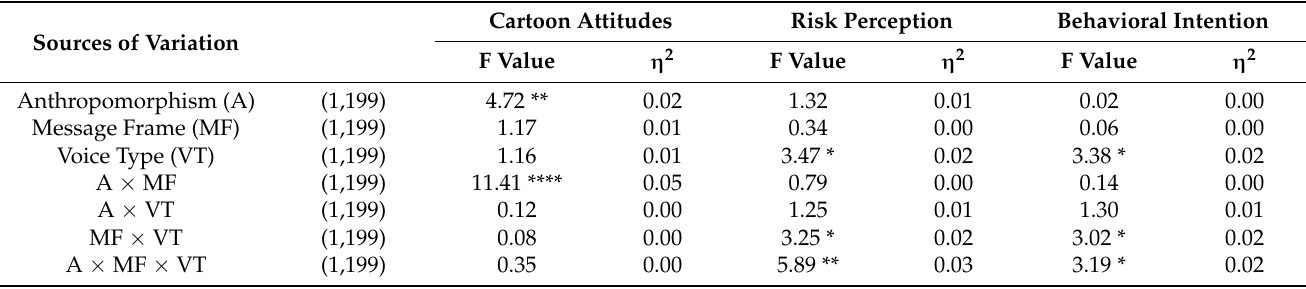
Table 3. Effects on cartoon attitudes, risk perception, and behavioral intention.